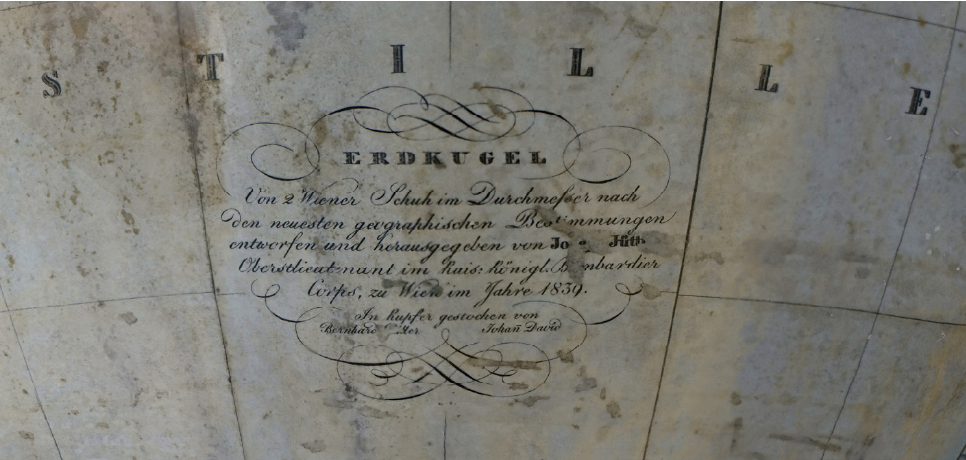
Figure 1. The German text of the cartouche. Source: Map Collection of the Faculty of Science, Charles University. (Translated: The globe measuring 2 Viennese feet in diameter reflecting the latest geographical knowledge was designed and published by Josef Jüttner, Artillery Lieutenant Colonel; engraved in copper by Bernhard Bitter and Johann